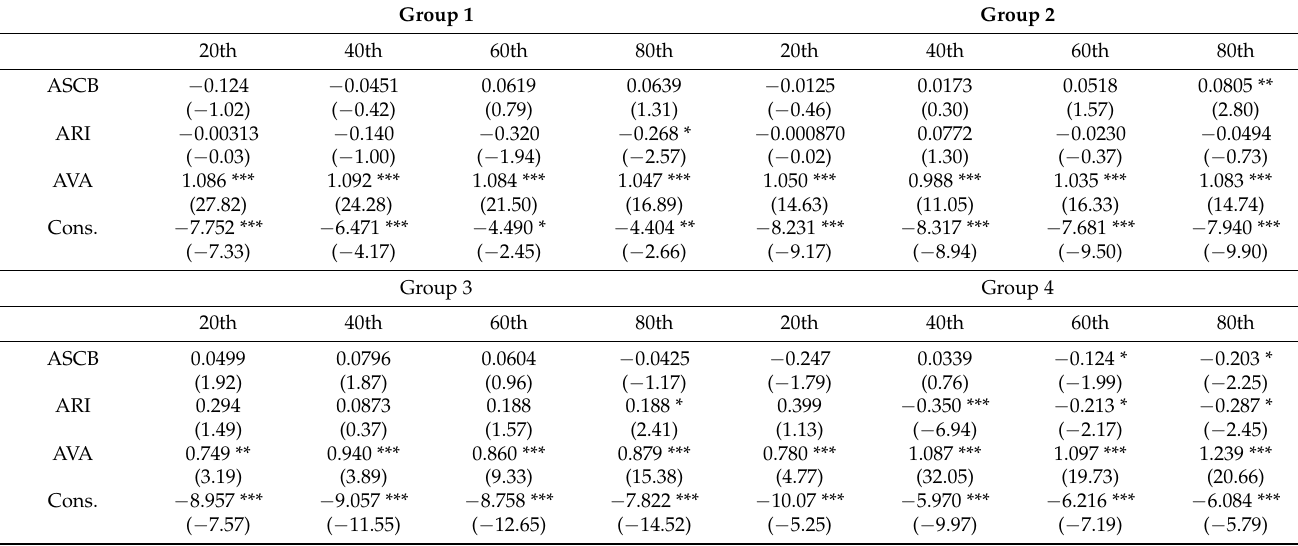
Table 5. Panel quantile regression.